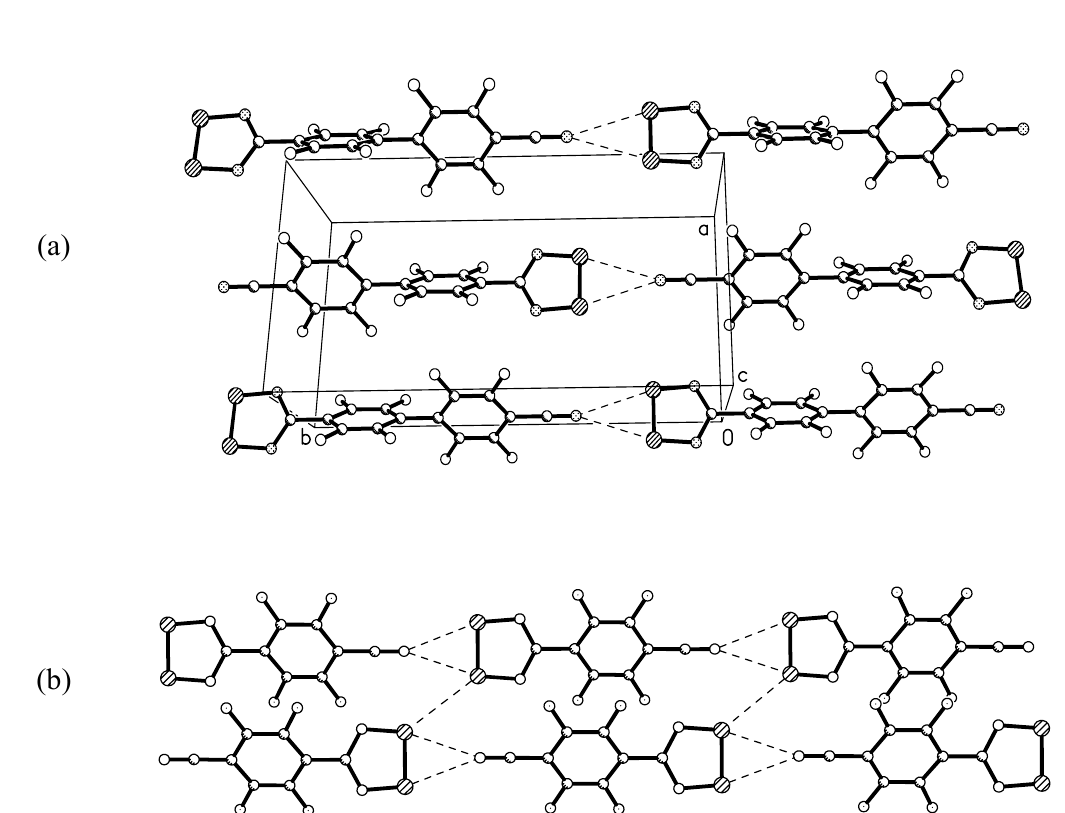
Figure 3. (a) Antiparallel alignment of chains of 4 ; and (b) antiparallel alignment of chains of 1 α